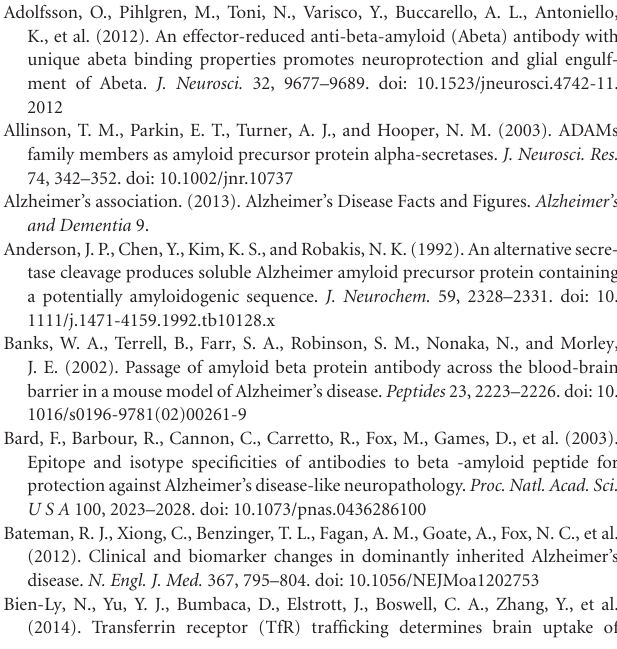
FIGURE 2 | Targeting immunotherapies for transport across the blood-brain barrier . (A) Bi-specific IgG antibodies targeting the transferrin receptor (TfR) and β -secretase (BACE). (B) Bi-functional IgG antibodies target A β with a single Fab fragment targeting the TfR fused